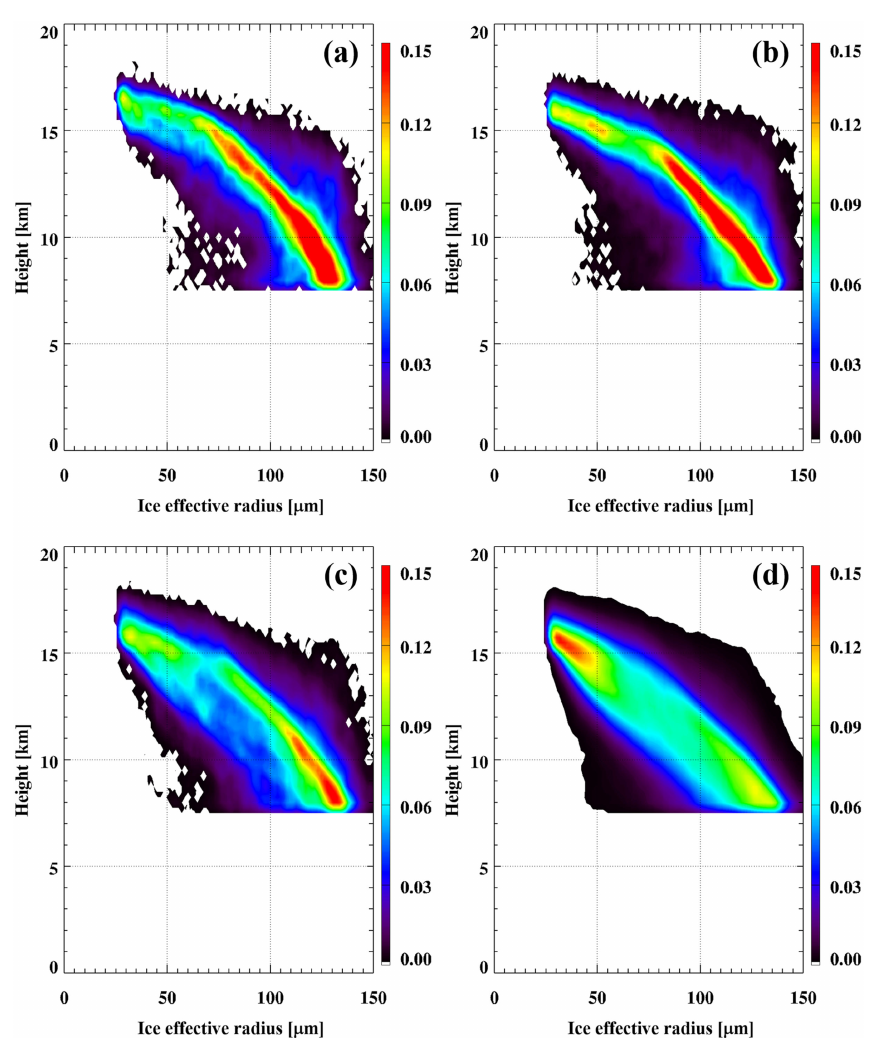
Figure 8. Same as Fig. 3 but for ice effective